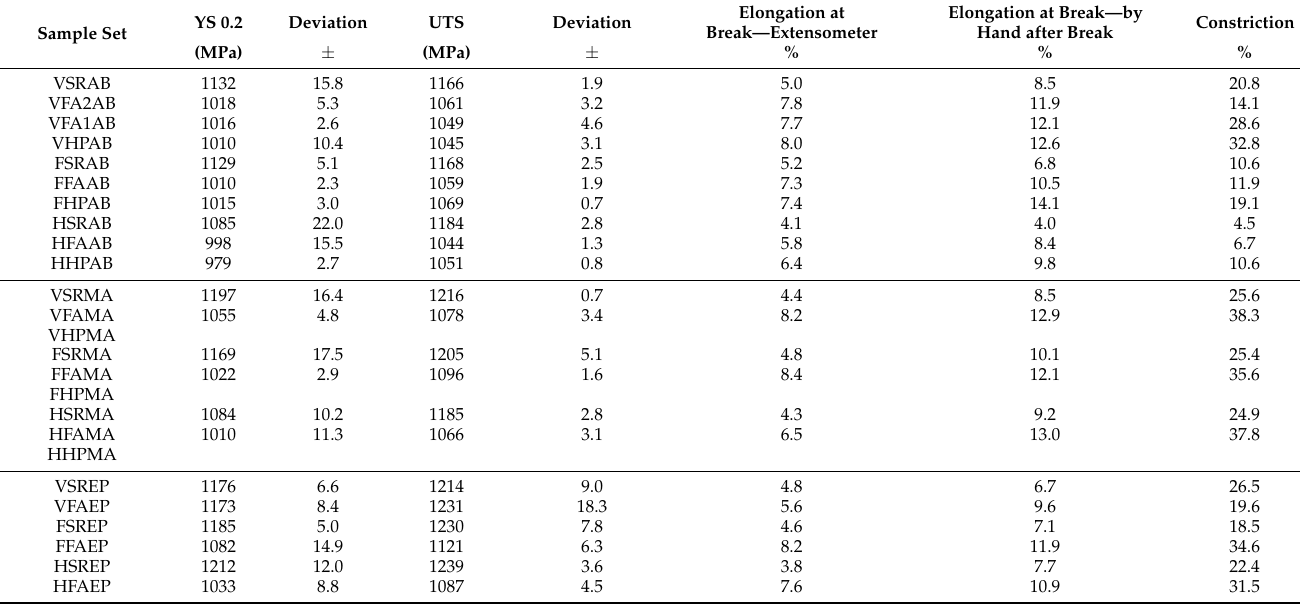
Table A1. Results of the Tensile Tests—Middle Values of 3 or 5